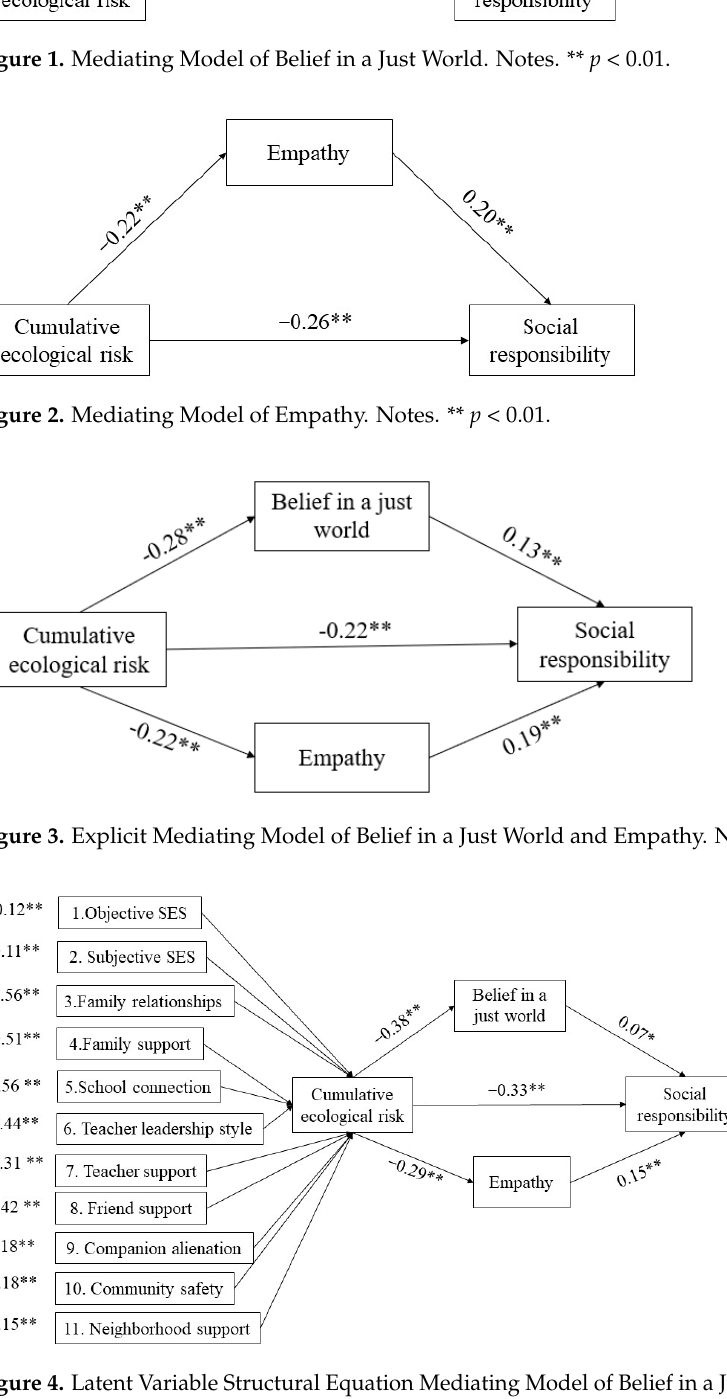
Figure 4. Latent Variable Structural Equation Mediating Model of Belief in a Just World and Em- pathy. Notes. * p < 0.05, ** p <